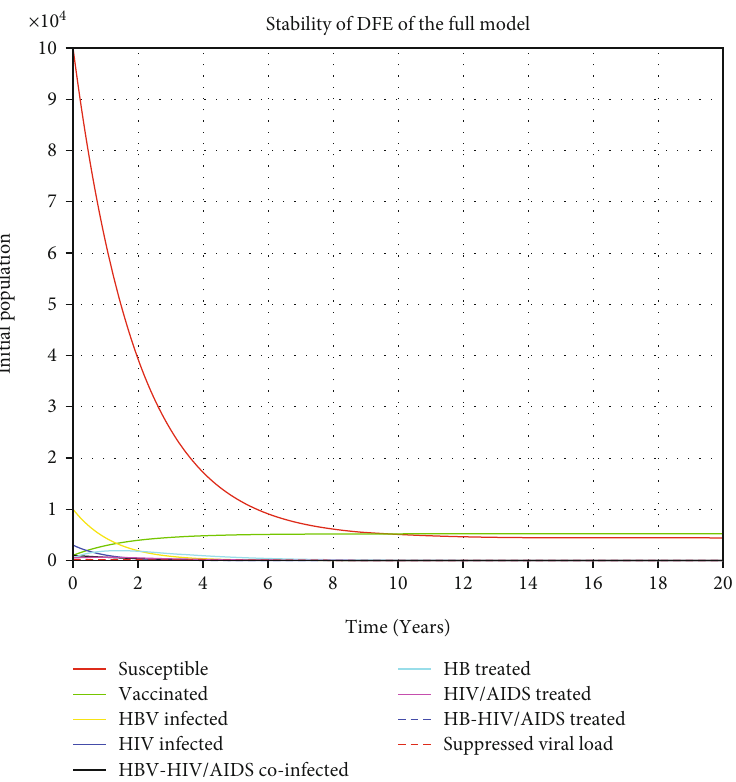
= 0 : 046 , ω = 0 : 09 , and μ = 0 : 5 B eff